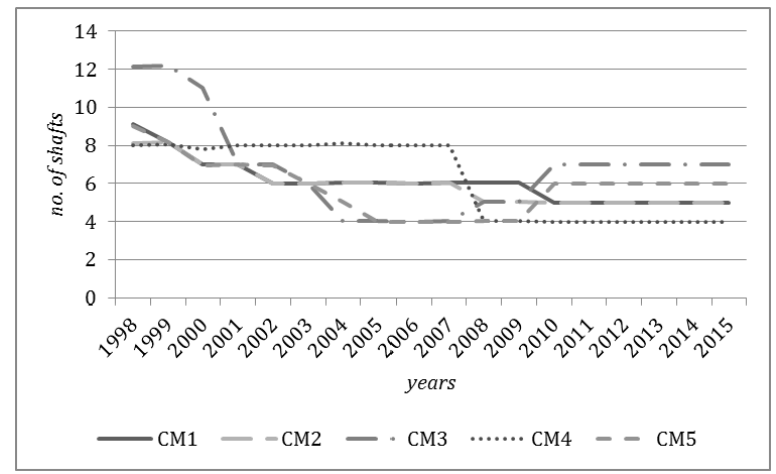
Figure 10. Number of shafts in examined hard coalmines over the period 1998–2015. Source: own work.